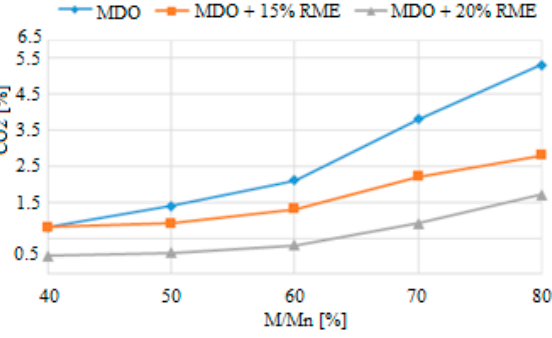
Figure 6. CO 2 content in exhaust gas as a function of the engine load for different kinds of fuel at a constant rotational speed n = 220 rpm. constant rotational speed n = 220